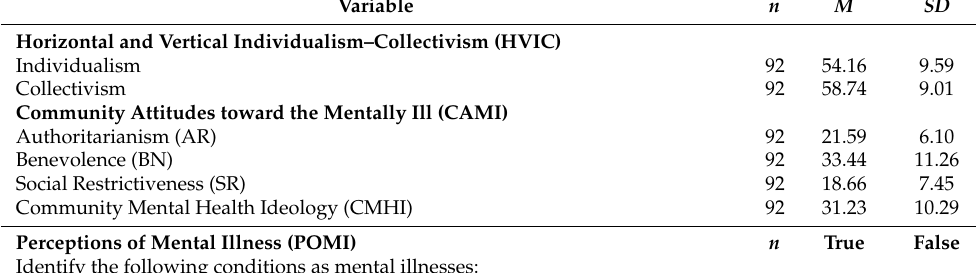
Horizontal and Vertical Individualism–Collectivism (HVIC)